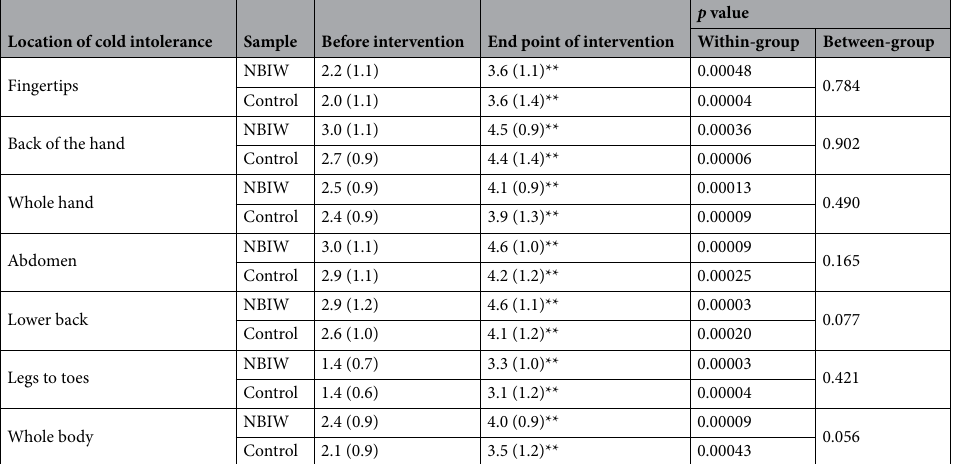
Table 7. Subjective symptoms of cold intolerance. NBIW neutral bicarbonate ionized water. Control: n = 27, NBIW: n = 25. Values are shown as mean ( SD ). Within-group comparison: Significant differences were found compared with before use (** p < 0.01: Wilcoxon signed rank test). Between-group comparison: No significant differences between group (Wilcoxon rank sum test).